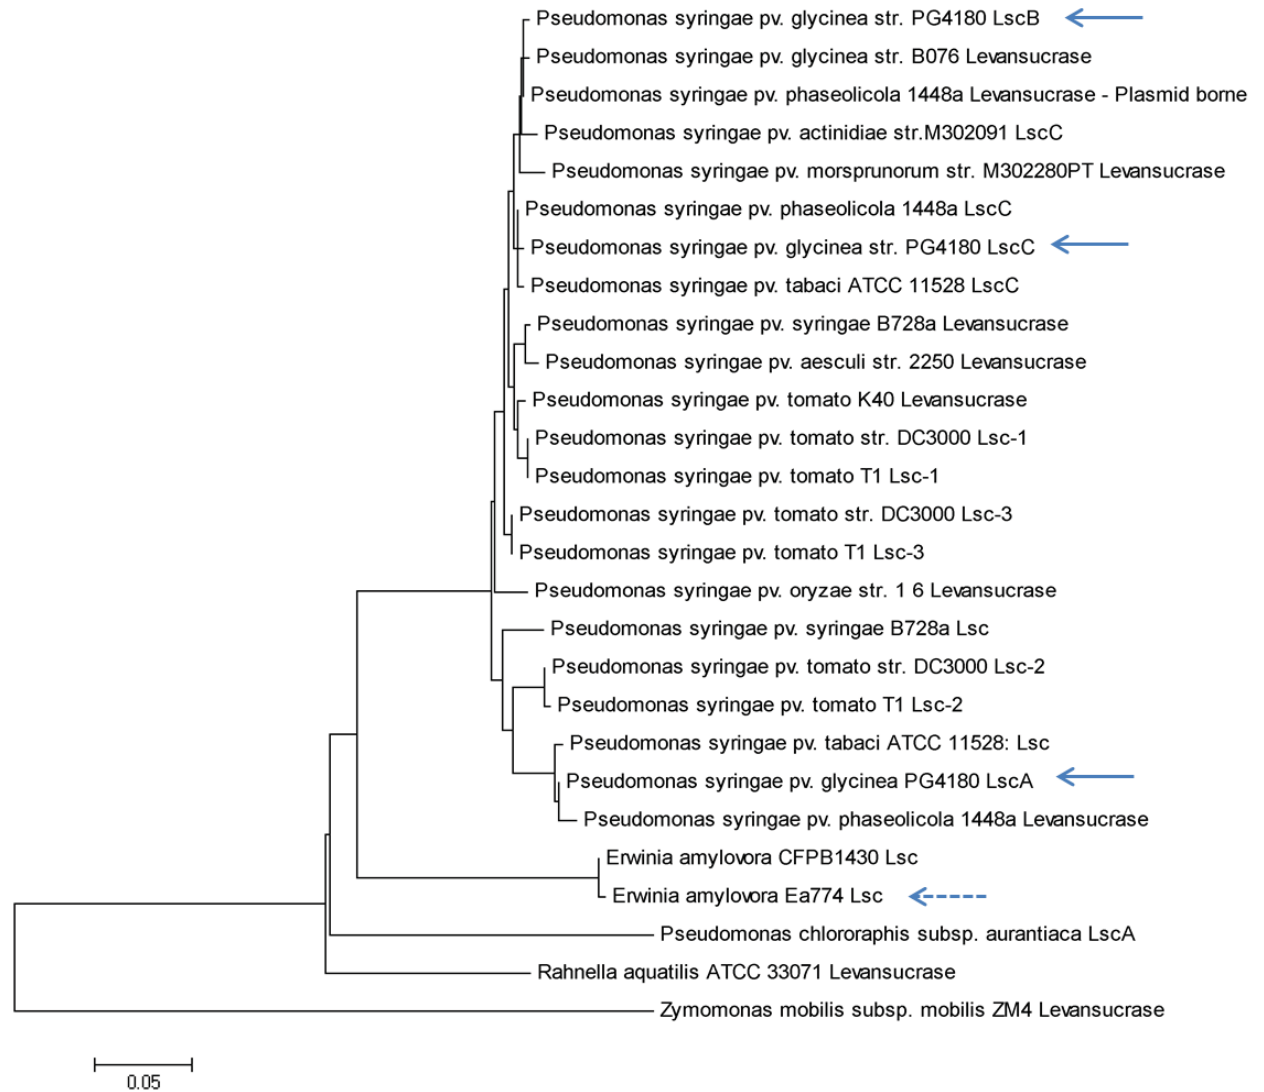
Figure A1. Neighbor-Joining phylogenetic tree generated by Mega 5.05 for known Lsc amino acid sequences of P. syringae strains, Erwinia amylovora , Rahnella aquatilis and Zymomonas mobilis . The blue arrows represent Lsc in PG4180 while the dashed arrow represents Lsc of